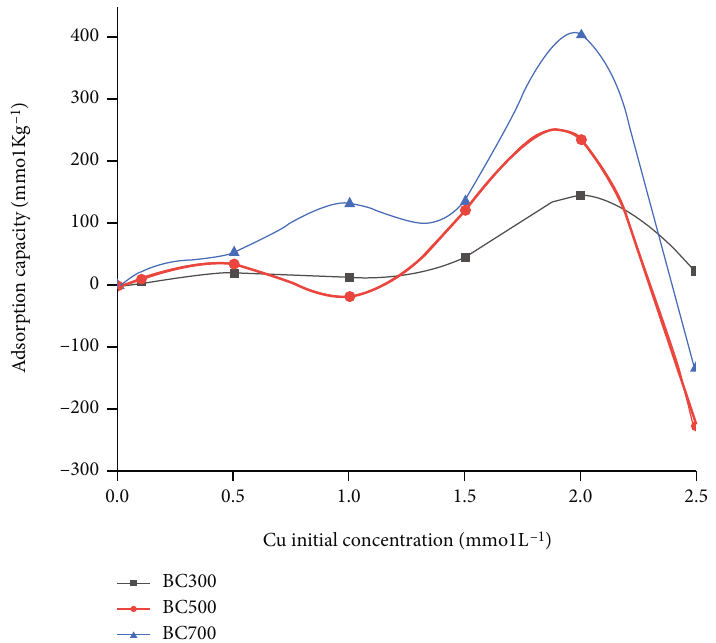
Figure 8: Adsorption of Cu 2+ in straw with di ff erent concentrations of heavy metal ions.